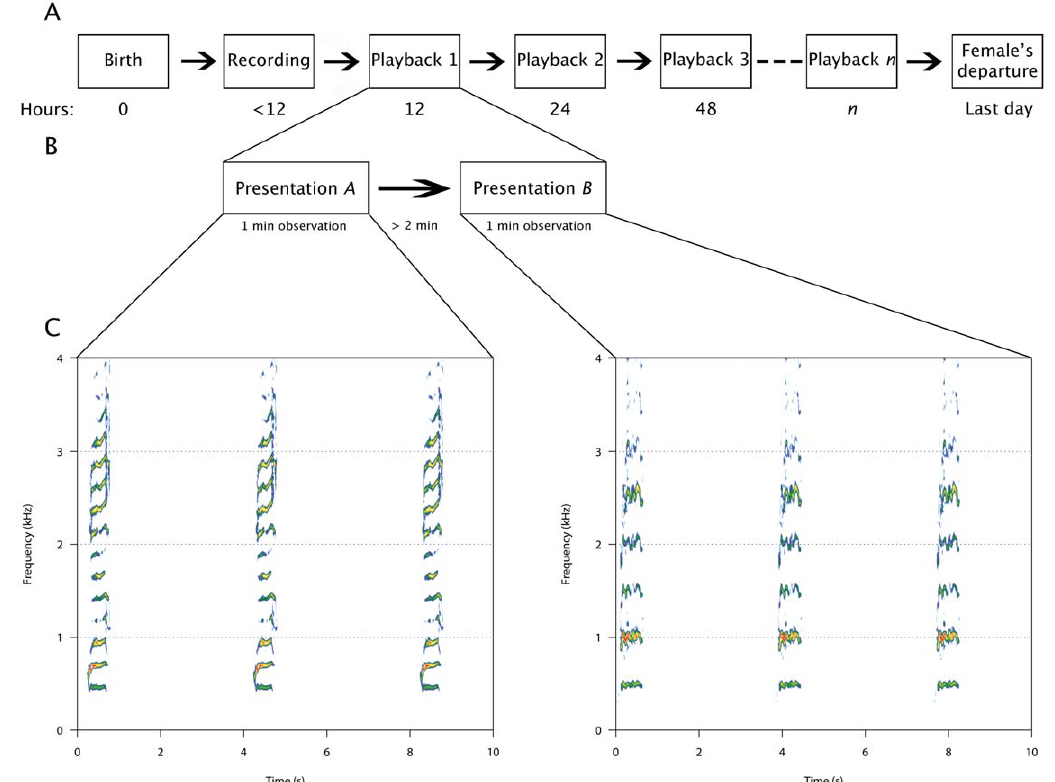
Figure 1. Experimental design. A. Females received the first playback within 12 hours of the birth of their pup, followed by another at 24 hours and every 24 hours until they departed the colony at the end of the perinatal attendance period. B. Each playback trial consisted of two presentations separated by a minimum of 2 minutes. During each presentation the responses of the female were recorded for 1 minute. The presentation order of own and non-filial pup’s female attraction calls (FAC) was randomised. C. Presentations consisted of a single FAC repeated three times separated by 3 seconds of silence. Spectrograms were made using Seewave [48].